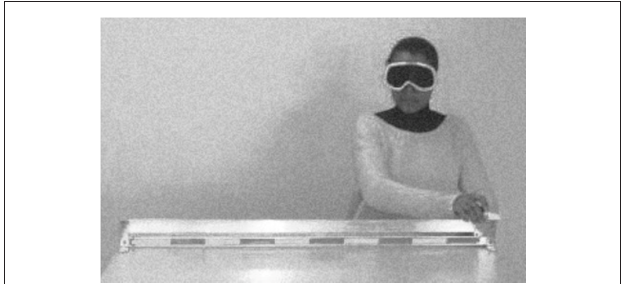
Figure 1 | Participant wearing the goggles and positioned in the apparatus.